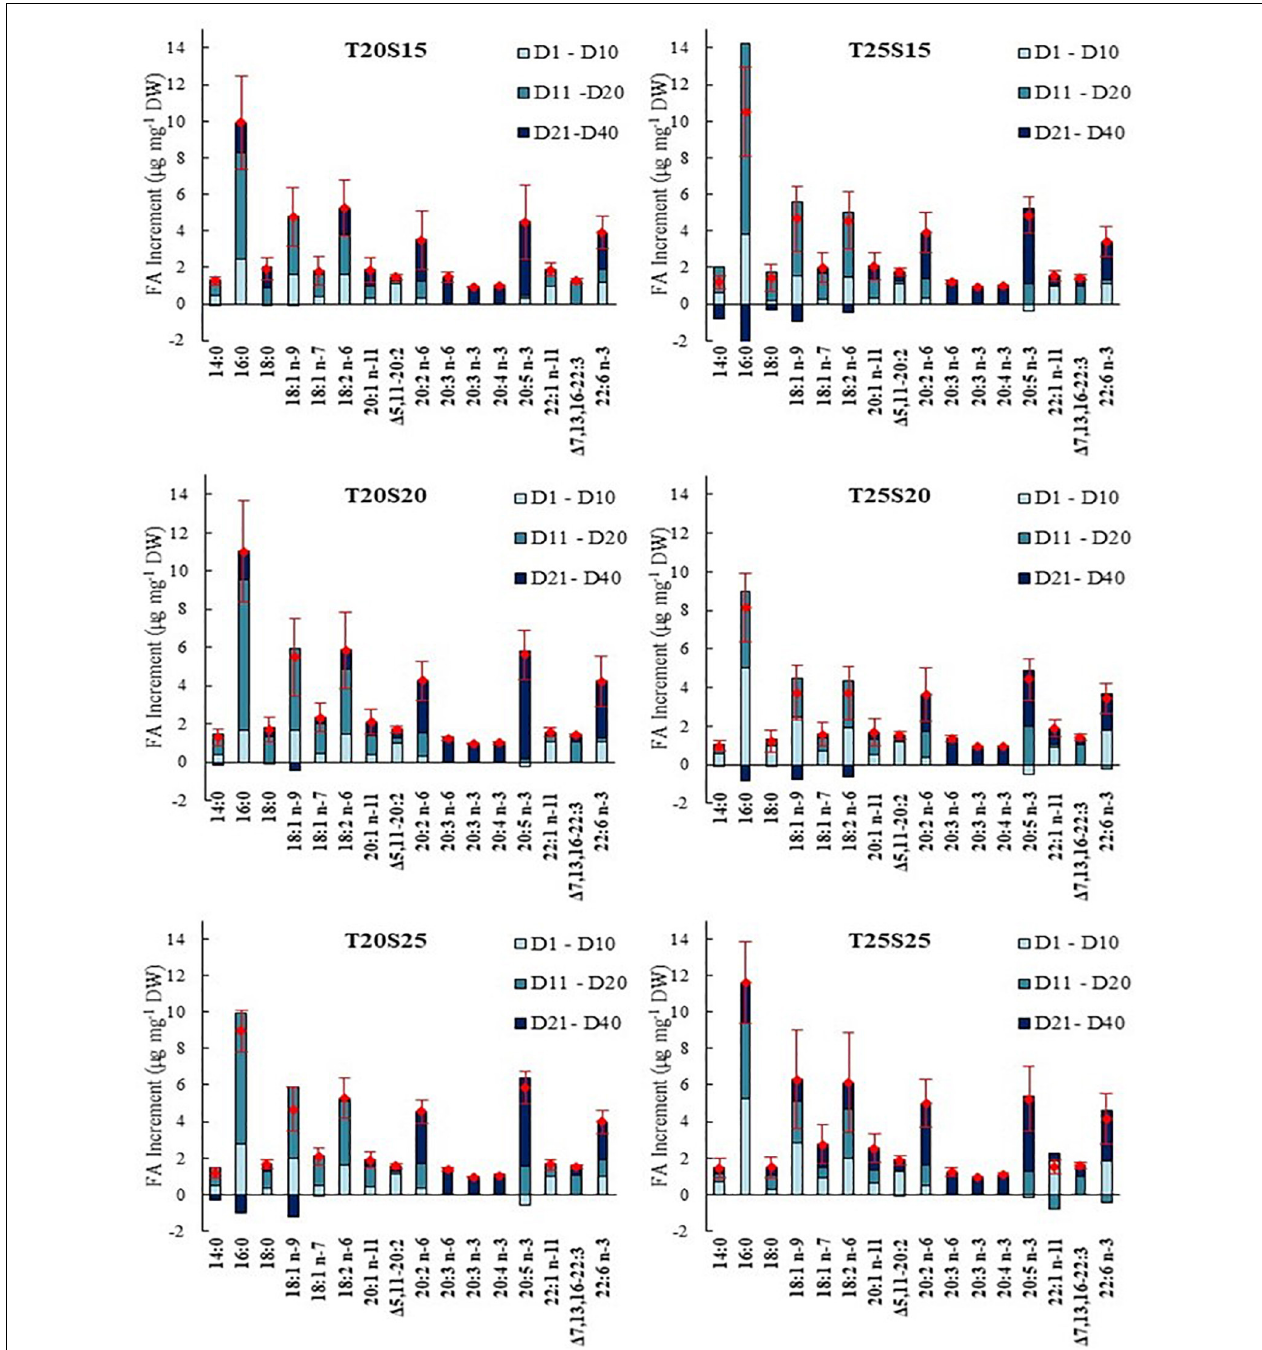
FIGURE 4 | Evolution of the fatty acids (FA) in Hediste diversicolor fed a commercial aquafeed over time (D1–D10, D11–D20, and D21–D40) under different combinations of water temperature (T—20 and 25 ◦ C) and salinity (S—15, 20, and 25). Red diamond represents the final average increment recorded ( ± SD) ( n = 5).